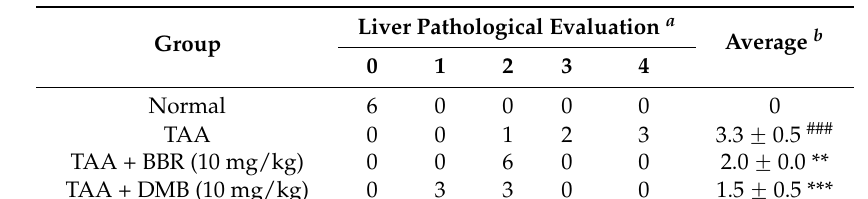
Table 1. Treatment effects of demethyleneberberine (DMB) on liver pathological changes in mice with thioacetamide (TAA)-induced a Values represent the number of mice rated with a given level of pathological